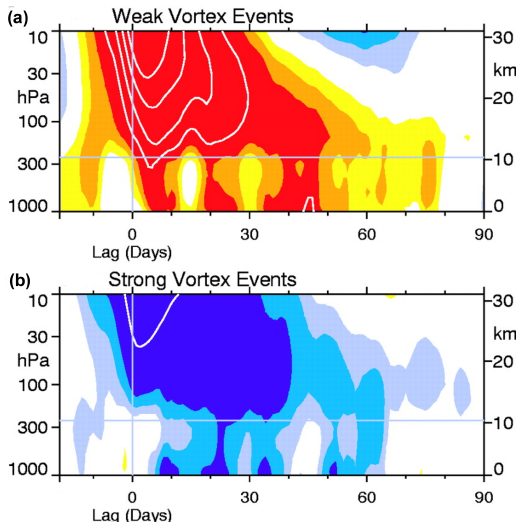
Figure 17. Dripping paint diagram. Composites of a non- dimensional NAM index (Baldwin and Dunkerton, 2001) show- ing descent of NAM anomalies from the stratosphere into the troposphere for (a) 18 weak vortex events (e.g. SSWs) and (b) 30 strong vortex events. The approximate location of the extra- tropical tropopause is indicated by the horizontal line. In panel (a) the weak events corresponding to negative values of the index (yel- low and red shading) are determined by the dates on which the 10hPa annular mode values cross − 3 . 0. In panel (b) the strong events corresponding to positive values of the index (blue shading) are determined by the dates on which the 10hPa index crosses + 1 . 5. The shading is at intervals of 0.25 and the white contours at inter- vals of 0.5. Adapted from Fig. 2 of Baldwin and Dunkerton (2001). © American Association for the Advancement of